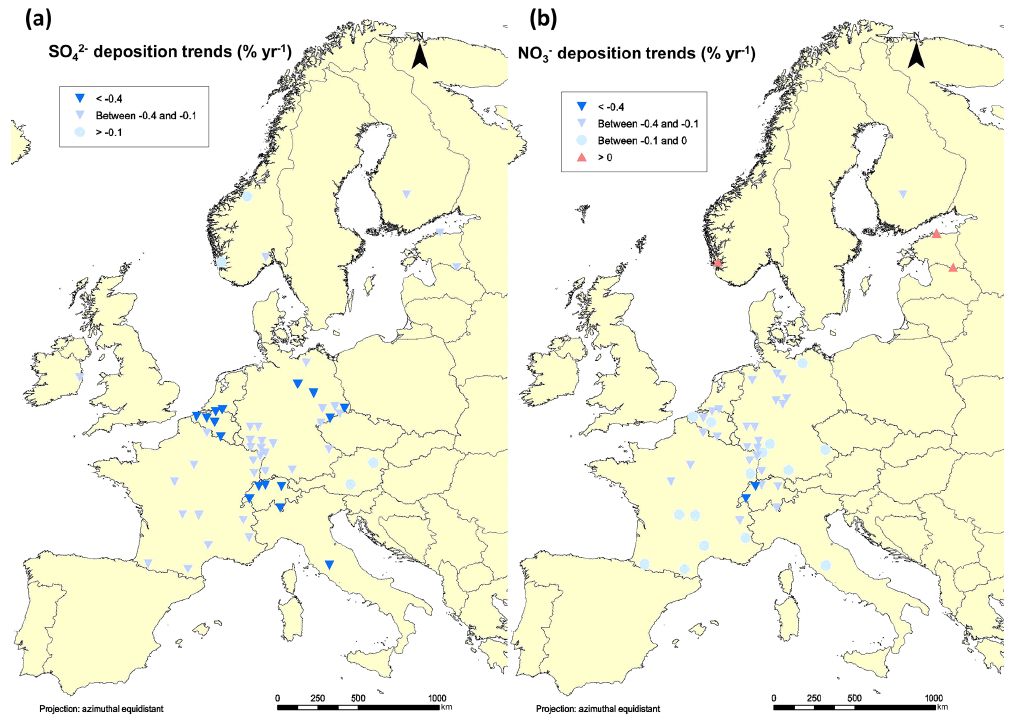
Figure 8. Temporal trends in (a) throughfall SO 2 − the seasonal Mann–Kendall test. Data span from 1999 to